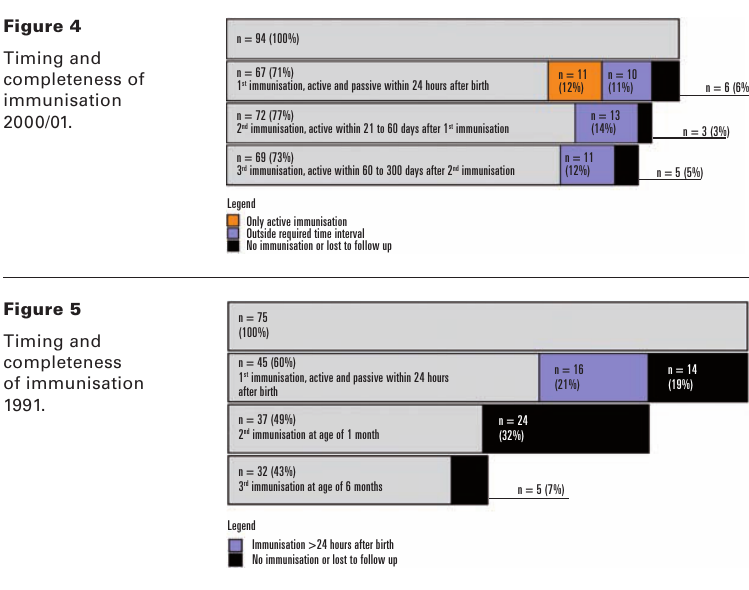
Figure 5 Timing and completeness of immunisation